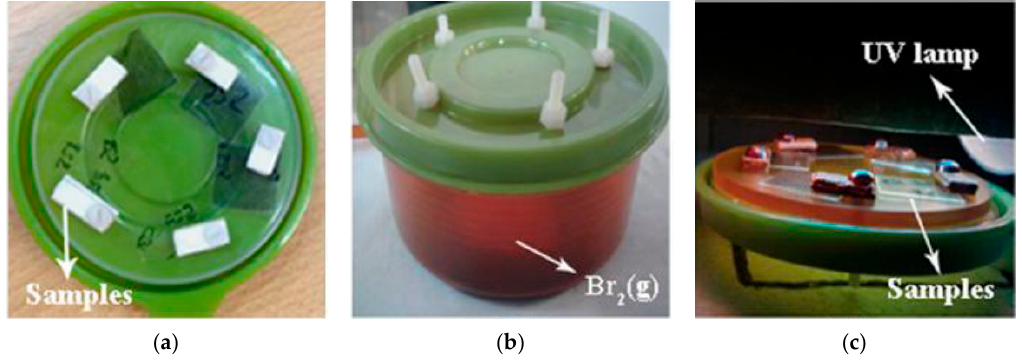
Figure 1. ( a ) Internal view of the cover in which sample holders were placed. ( b ) Container with liquid bromine in equilibrium with its vapour. The samples were located upside down on the lid; thus, the films were in contact with bromine vapours. ( c ) The lid was removed from the vessel and samples were placed face-up and